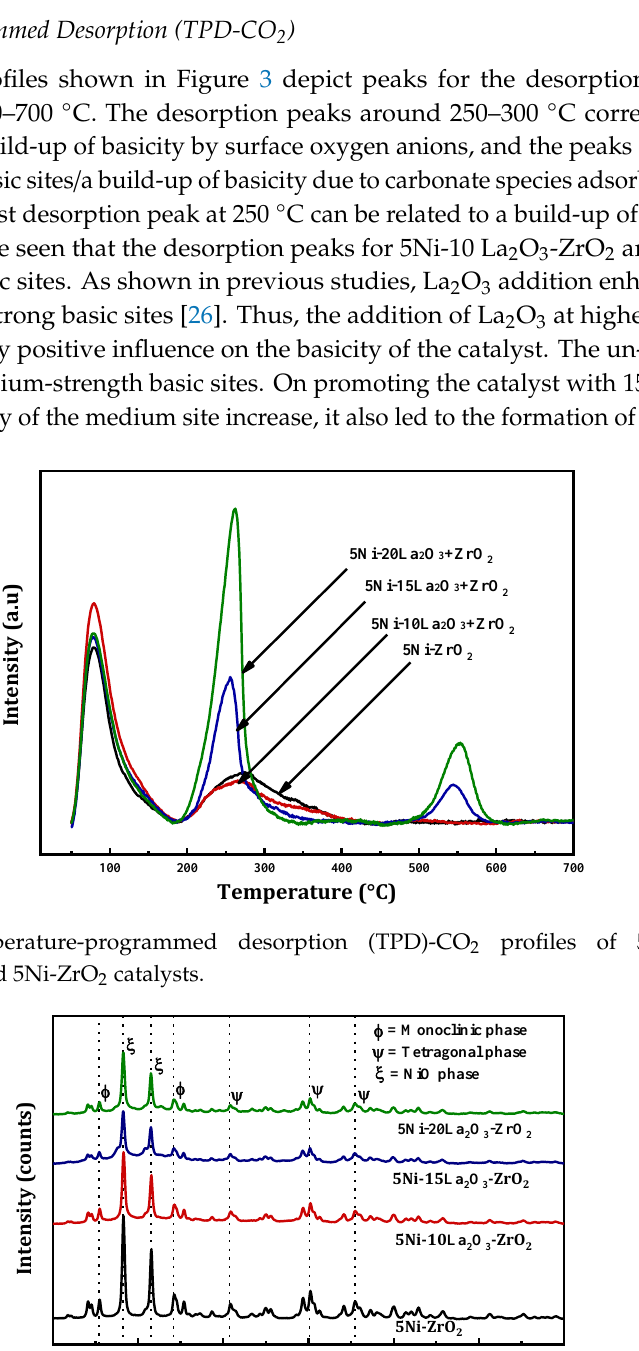
Figure 2. H 2 -temperature programmed reduction (TPR) profiles of 5Ni-ZrO 2 and La 2 O 3 -promoted 5Ni-ZrO 2 catalysts.